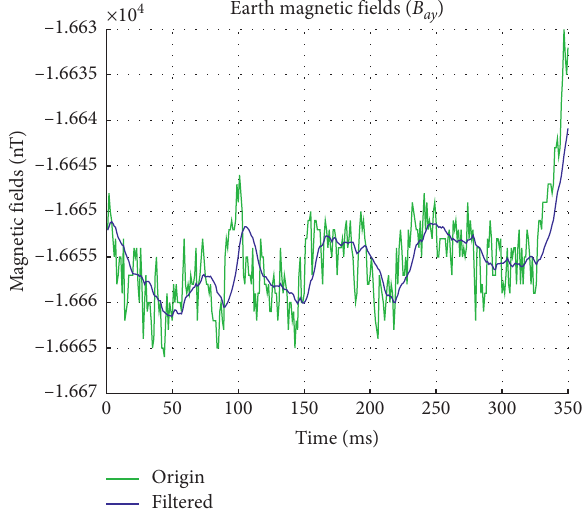
Figure 4: Earth’s magnetic fields when no vehicle is passing by, filtered by a MAF-1.